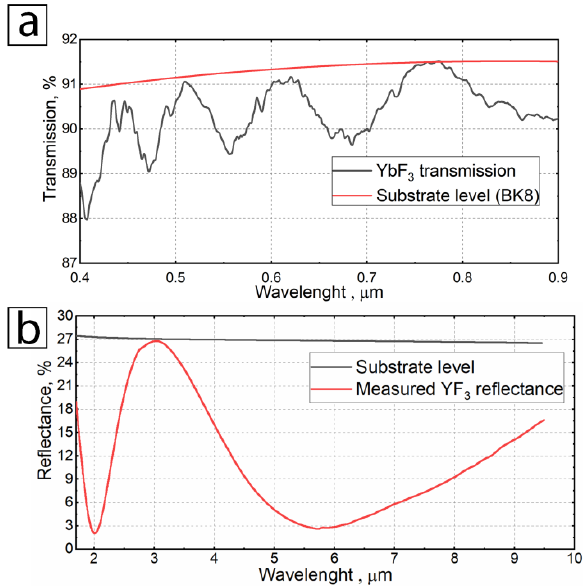
Figure 1. ( a )—transmission spectrum of an YbF 3 monolayer on a BK8 substrate; ( b )—reflection spectrum on a ZGP substrate.